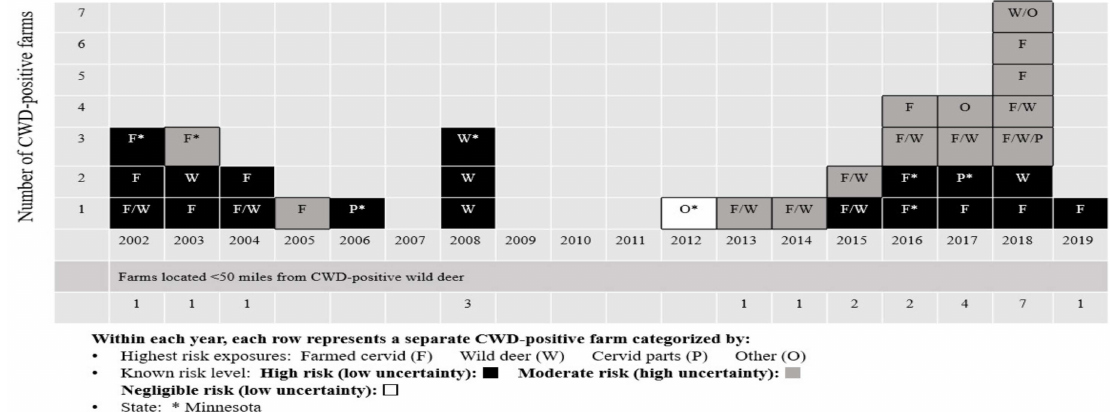
Figure 1. Highest transmission risks by year for Minnesota and Wisconsin CWD-positive cervid